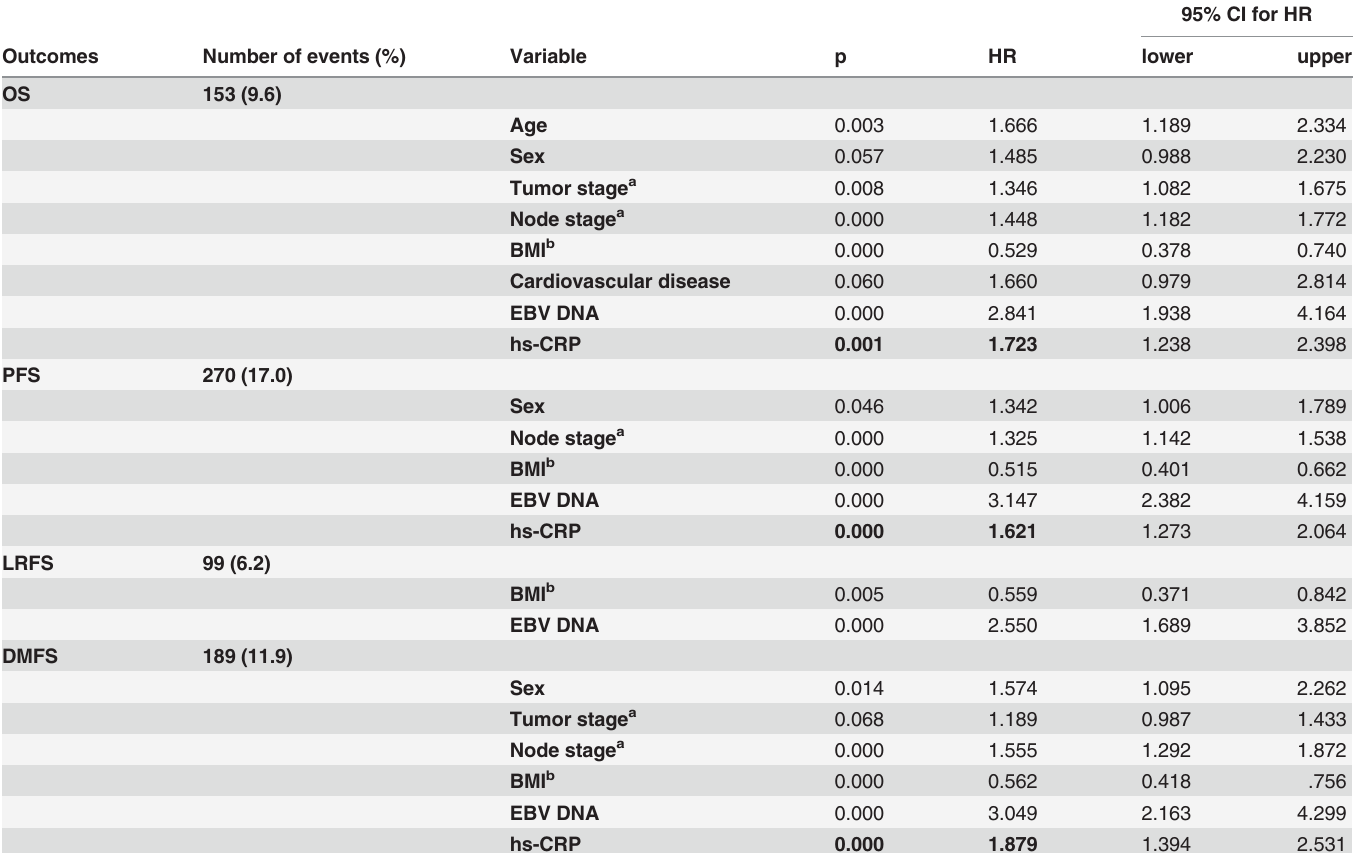
Table 2. Multivariate analysis of prognostic factors for NPC